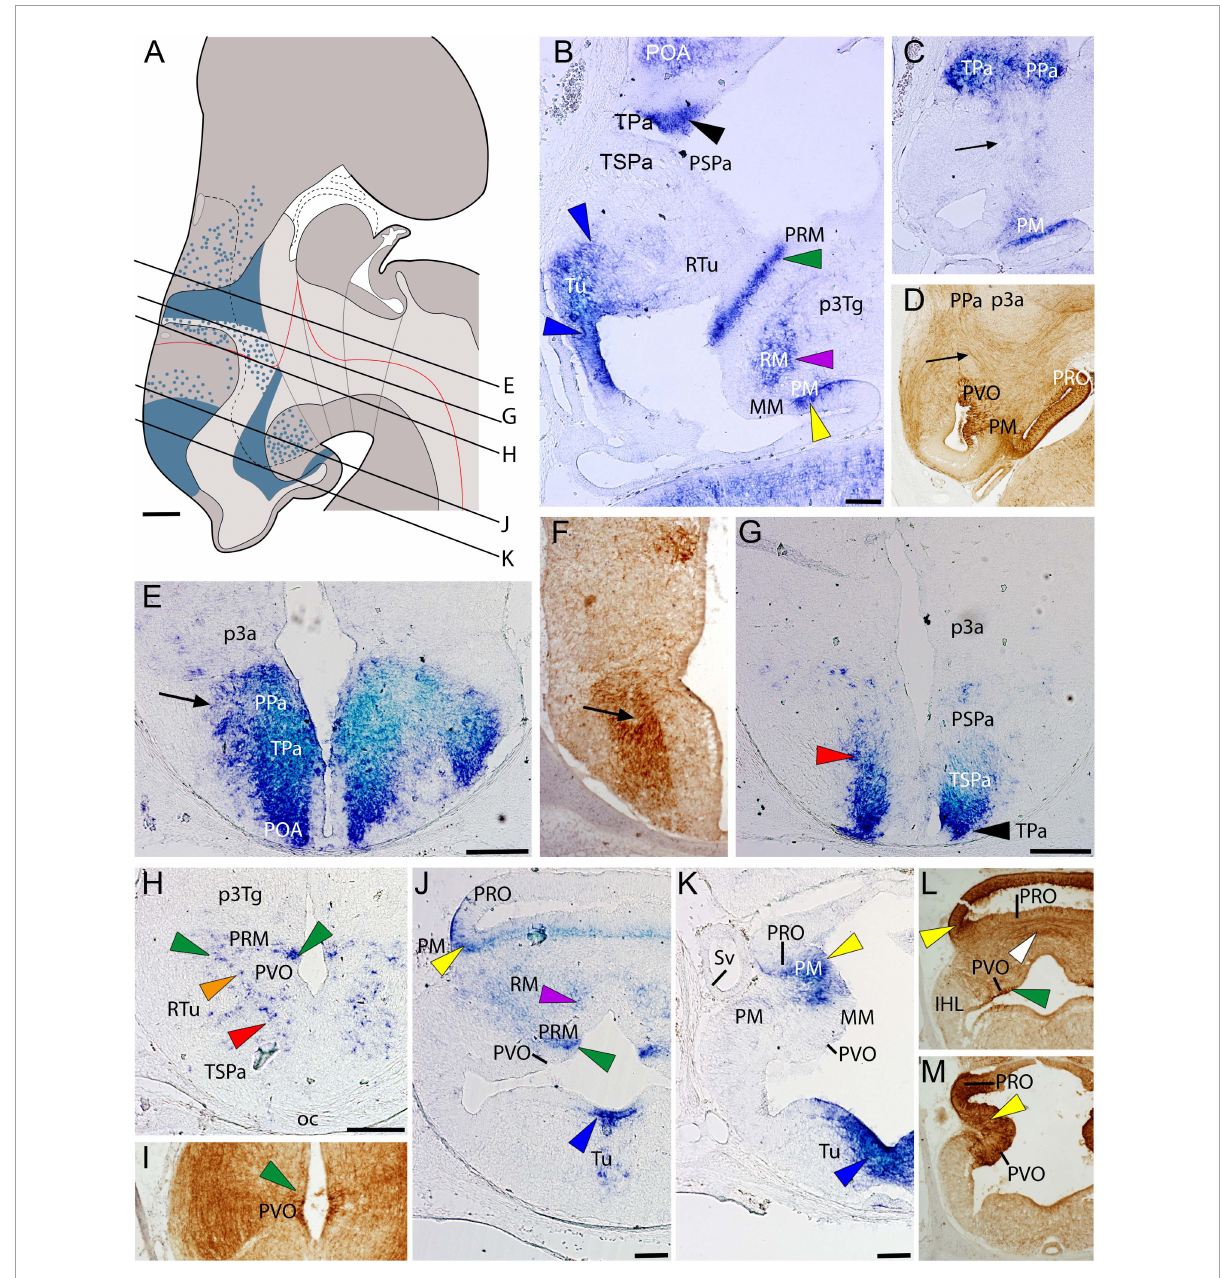
FIGURE2 Regionalization of the hypothalamus of Scyliorhinus canicula at stage 32 based on the expression of ScOtp (blue color in A ) by means of in situ hybridization (B,C,E,G,H,J,K) and immunohistochemistry for 5-HT (D,F,I,L,M) in sagittal (B–D) or transverse (E–M) sections. Scheme on (A) represents a maximal projection of the expression found in sagittal and parasagittal sections. Lines represent the level of transverse sections. Ventricular labeling is represented with solid color while mantle cells are represented with dots. Black arrowheads point expression in the TPa. Blue arrowheads point expression in the Tu. Green arrowheads point expression in the PRM. Yellow arrowheads point expression in the PM. Purple arrowheads point expression in the RM. Red arrowheads point ScOtp -expressing cells in TSPa. Orange arrowhead points ScOtp -expressing cells in RTu. Arrows in (C,D) point the tracts of the medial forebrain bundle. For abbreviations, see list. Scale bars: 125 µ